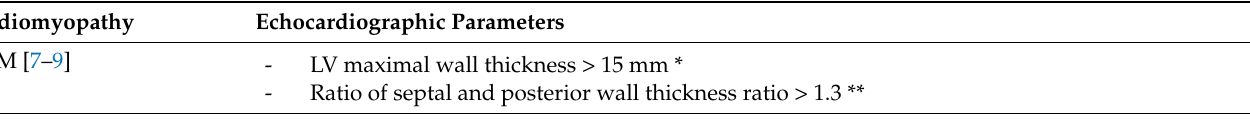
Table 1. Echocardiographic criteria for the diagnosis of cardiomyopathy.